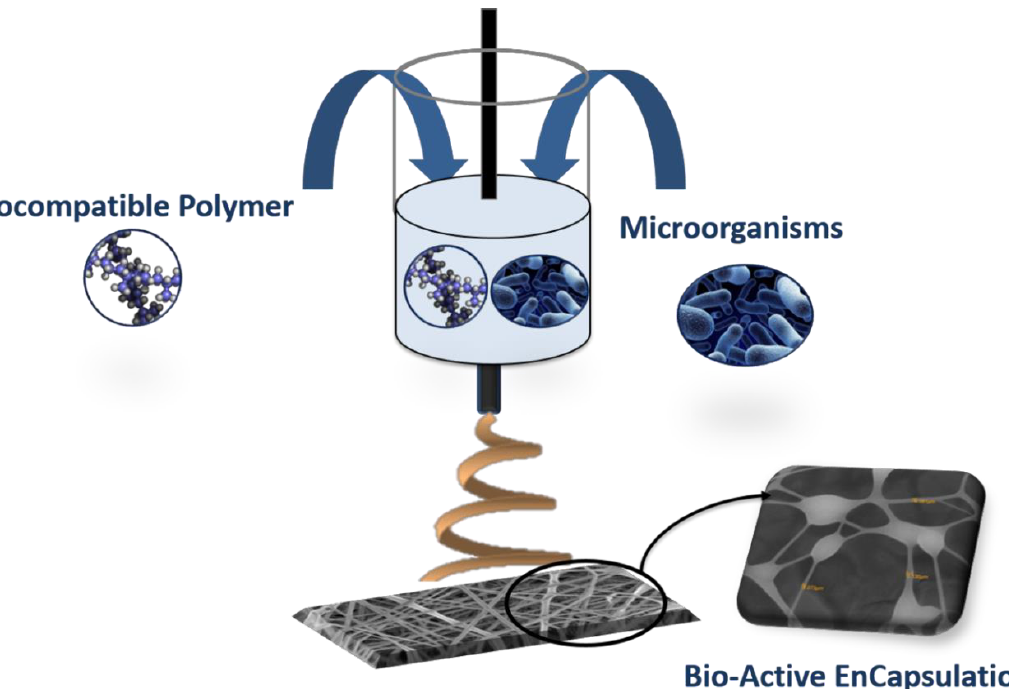
Scheme 1. Sketch of electrospun nanofiber-based bio-composite obtained by starting from a water-based polymeric solution, containing 5wt% of polyethylene oxide (PEO, Mw = 600 kDa, purchased from Sigma Aldrich) and 10 wt% of environmental microorganisms, is selected as initial polymeric solution for the electrospinning process.